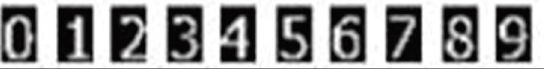
Figure 7: Te prestored ten-digit images.